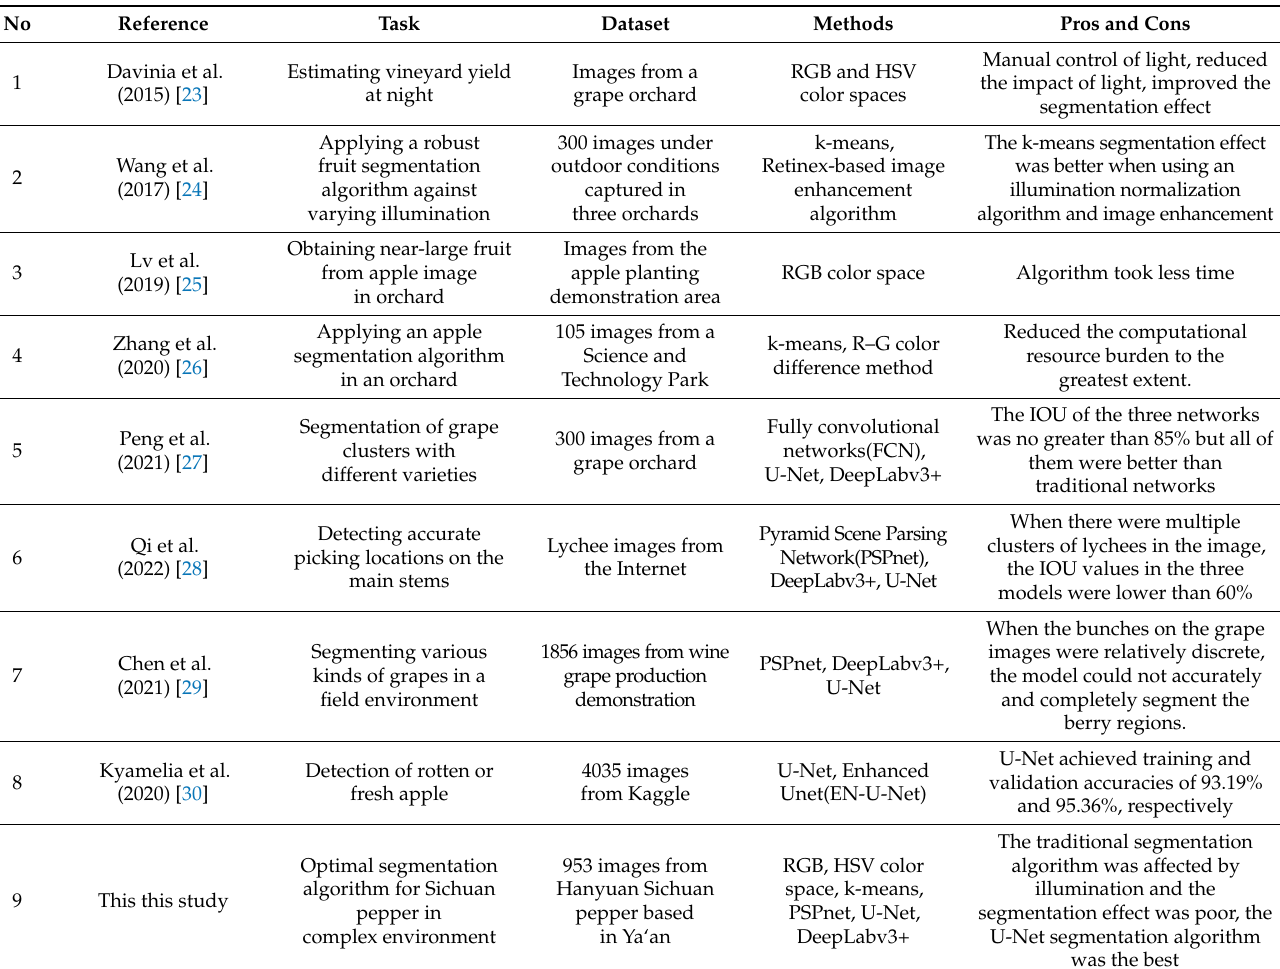
Table 4. Comparison of studies on various segmentation methods applied to